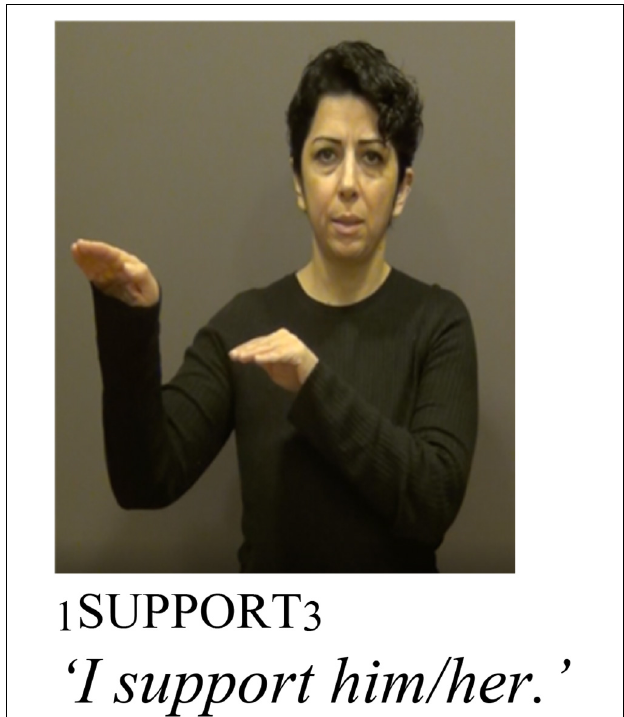
FIGURE 7 | Adapted with permission from Kelepir (2020c: P4,